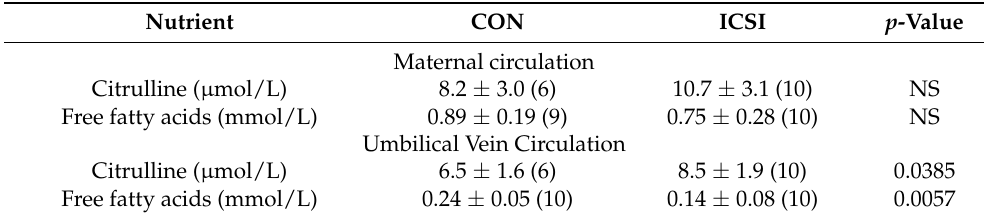
Table 3. Citruline and free fatty acid concentrations in maternal and umbilical vein circulations with natural conception and ICSI.